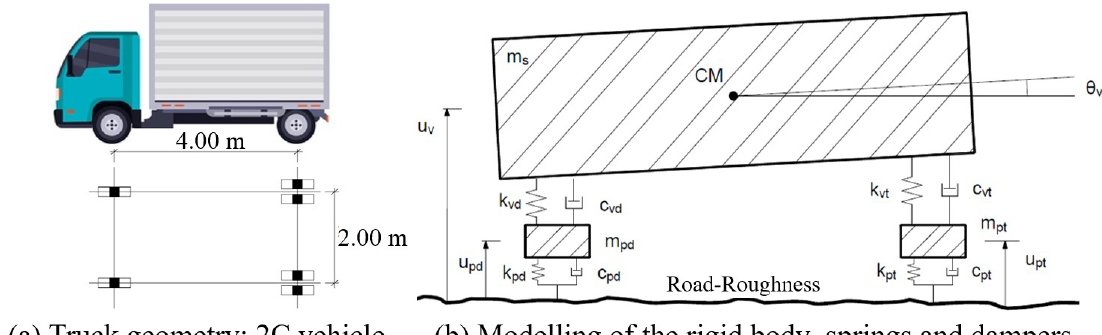
Figure 1. Model of the two-axle truck prototype.